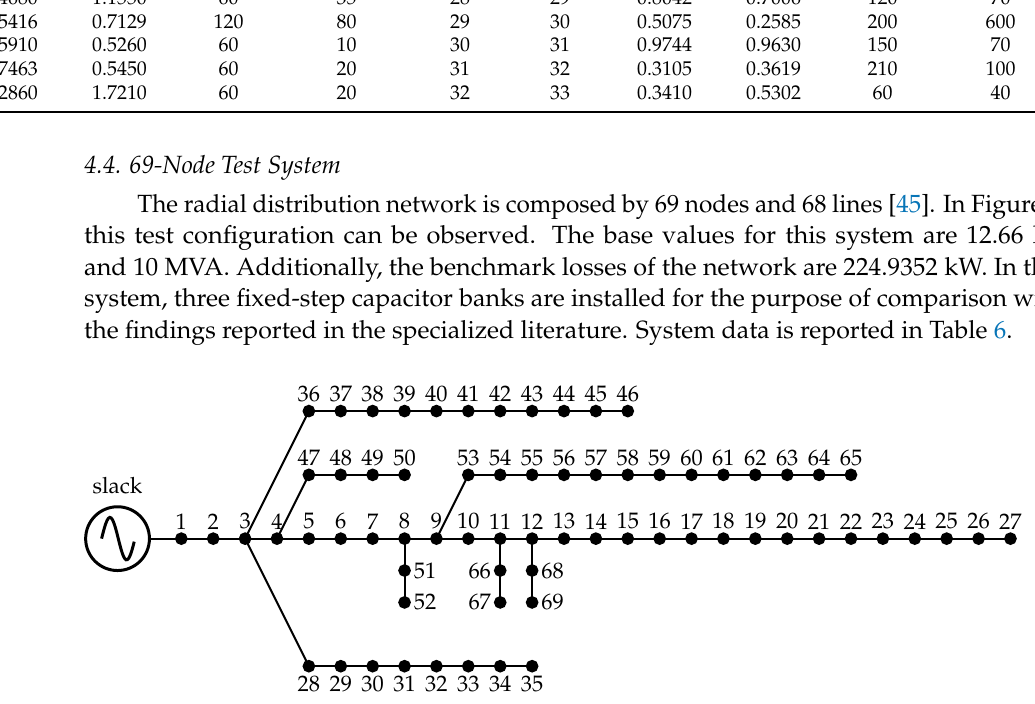
Figure 5. Schematic interconnection of the 69-node test